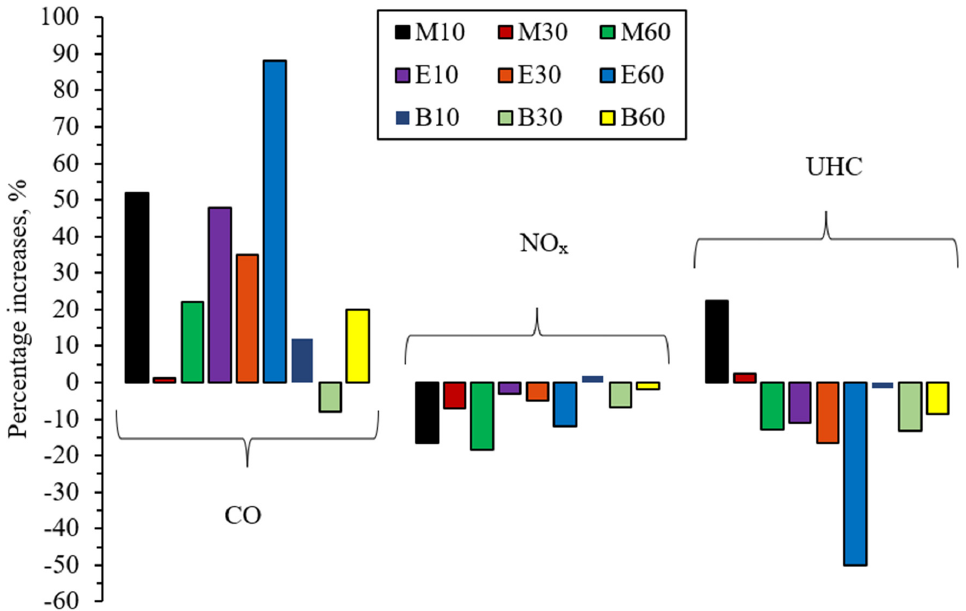
Figure 9. Percentage increases in CO, NO x , and UHC for methanol, ethanol, and butanol blends [61] . Table 5. Previous findings on emissions of SI engines fueled with alcohol–gasoline blend fuels.